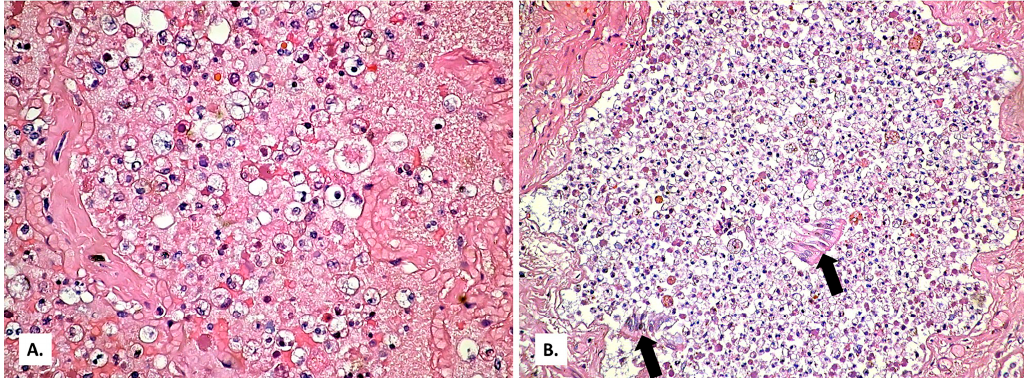
Figure 7. ( A ) Alveolus presenting a thickened wall with fibroblasts and abundant foamy macrophage content, on a background of granular eosinophilic material that fills the alveolus (HE × 400). ( B ) The exudate abundant in foamy macrophages also reaches the bronchial lumen which shows desquamated epithelium (arrows) (HE × 100).